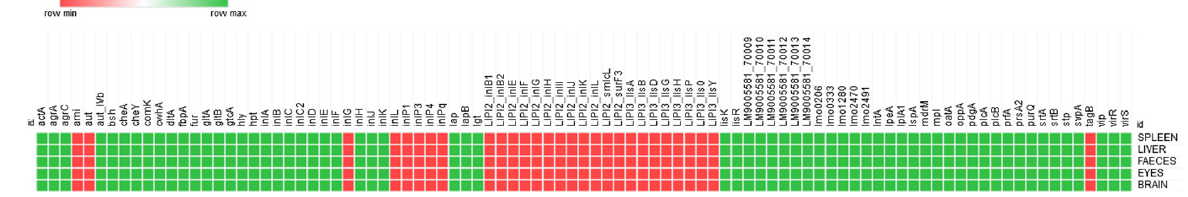
Figure 4. Heatmap virulence genes. In green, present genes; in red, missing genes.